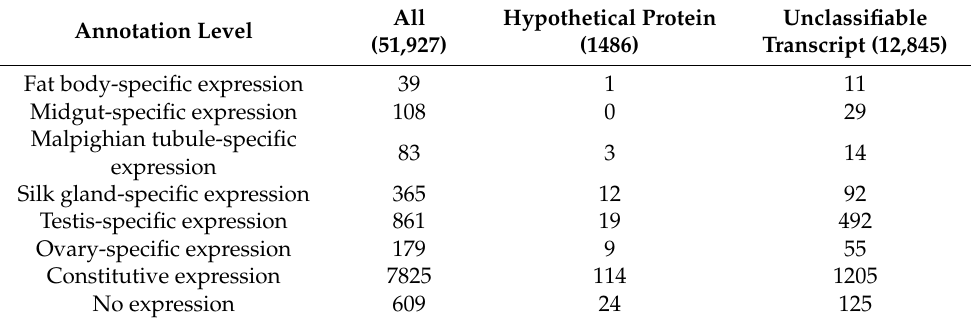
Table 5. Functional annotation of B. mori transcripts based on